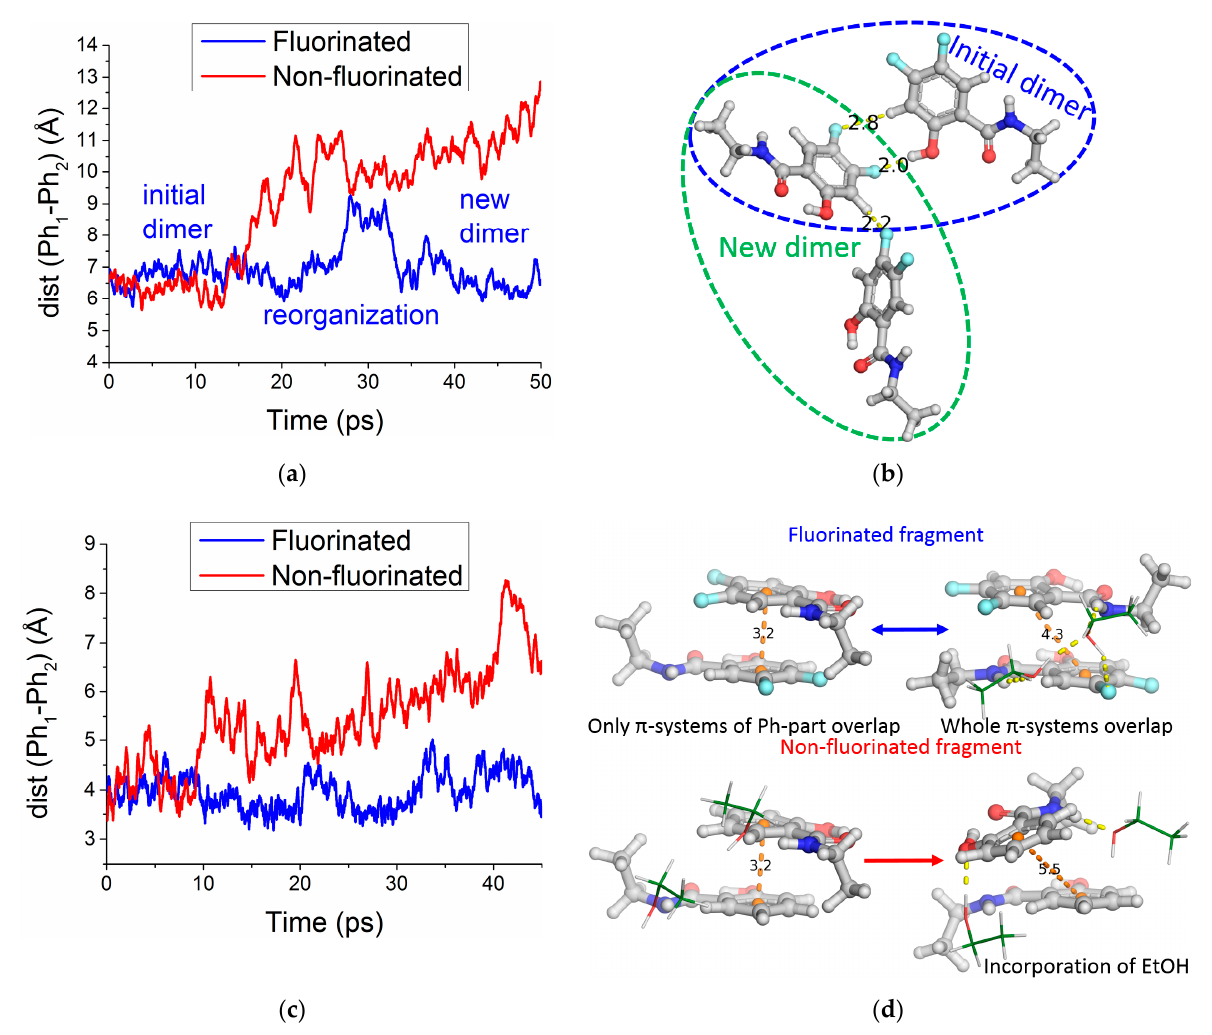
Figure 6. Results of MD simulations with QM/MM potentials of a sample dimer of two difluorosalicylamide fragments in comparison with their non-fluorinated analog in explicit ethanol/water solvent. ( a ) Evolution of the distance between centers of the phenolic rings of the two molecules (Ph 1 –Ph 2 distance) over the QM/MM-MD trajectory for the fluorinated dimer with initial C–H···F–C hydrogen bonds (blue line) and its non-fluorinated analog (red line); ( b ) visualization of the rearrangement of the intermolecular C–H···F–C hydrogen bonds of the fluorinated dimer (water and ethanol molecules are not shown). ( c ) Evolution of the distance between centers of the phenolic rings for initial fragments with π – π stacking for fluorinated (blue line) and non-fluorinated (red line) systems. Fluctuation of distance between centers of the phenolic rings of the fluorinated dimer reflects coexistence of the two variants of π – π stacking; ( d ) visualization of the changes in the two systems (some of the ethanol molecules are shown).